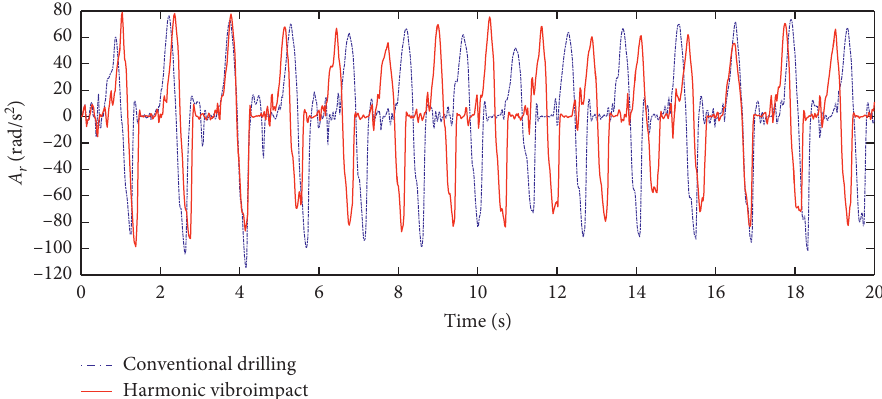
Figure 12: Time-history curves of angular acceleration under different drilling conditions.